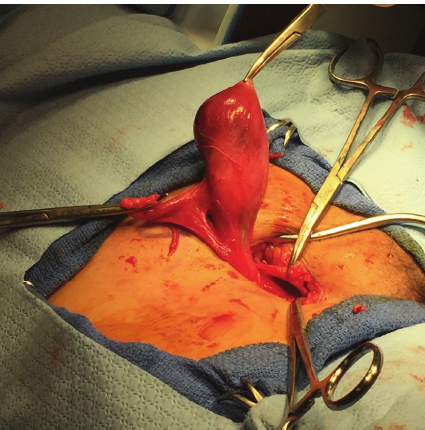
Figure 1: Mass arising from the right round ligament.